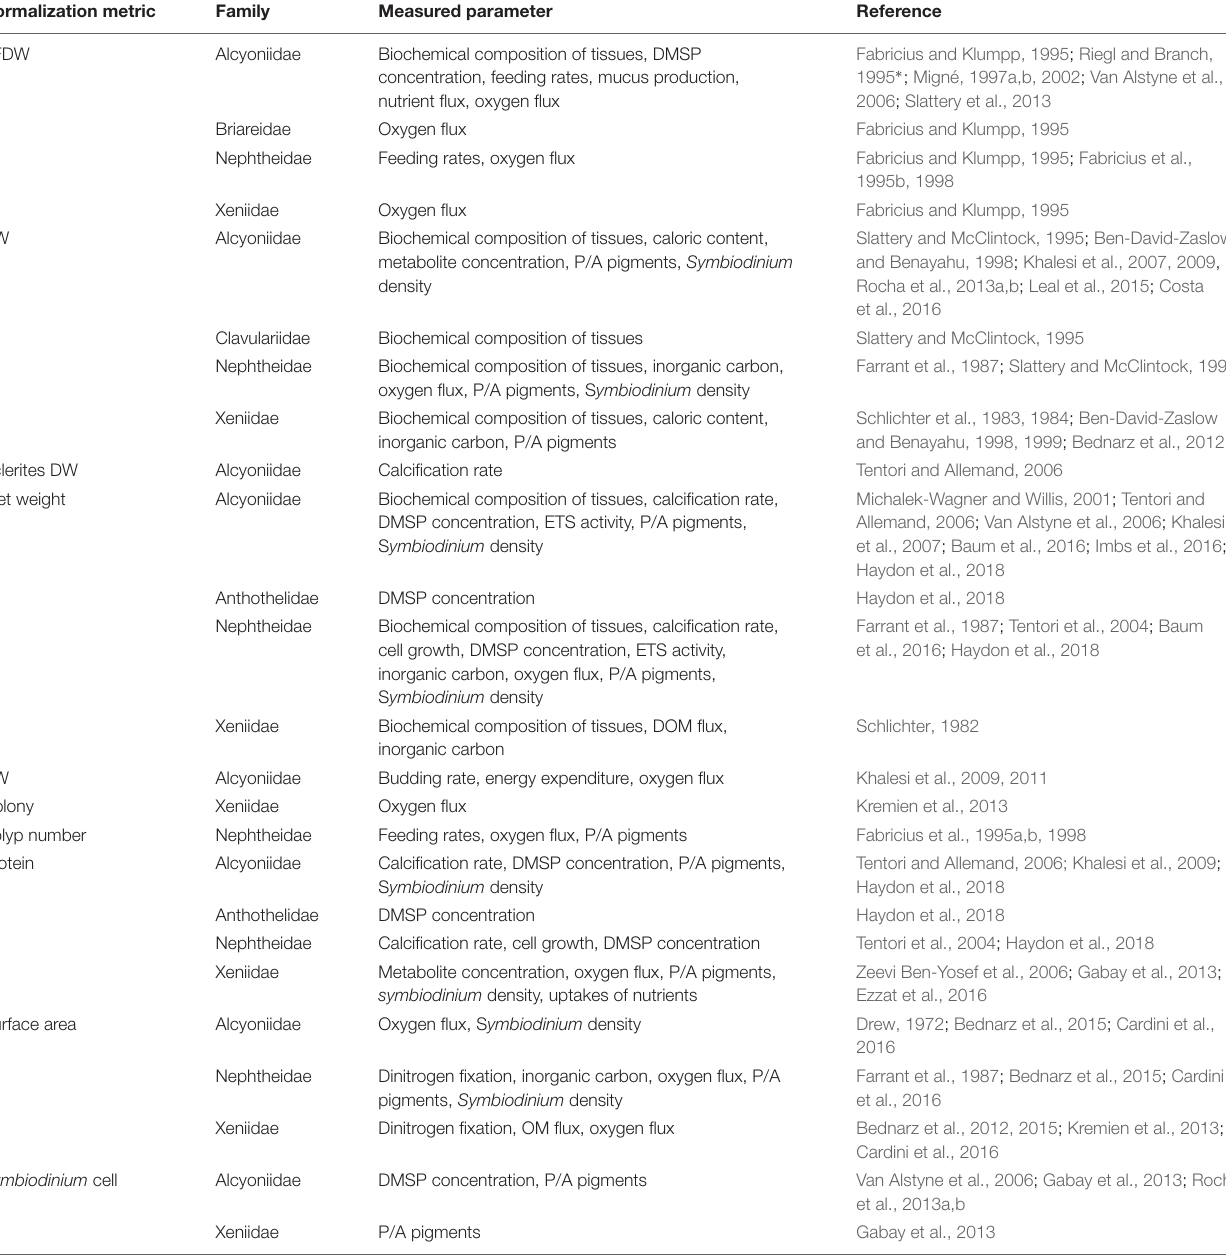
TABLE 1 | Summary about the range of metrics used in previous studies to normalize physiological processes in soft corals. Normalization